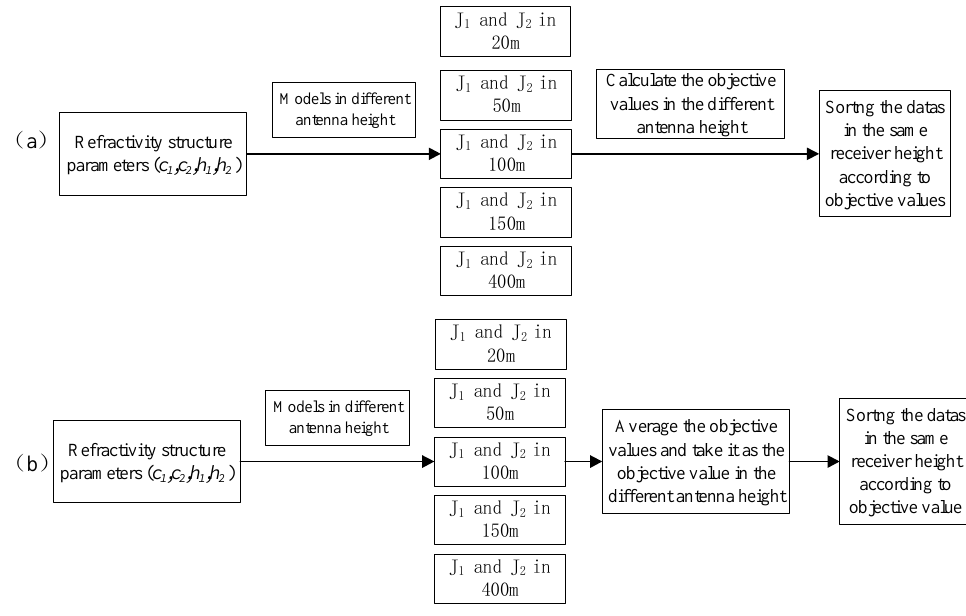
Figure 4. Flowchart of calculating objective value. ( a ) Consider the effect of antenna height. ( b ) Neglect the effect of antenna height .